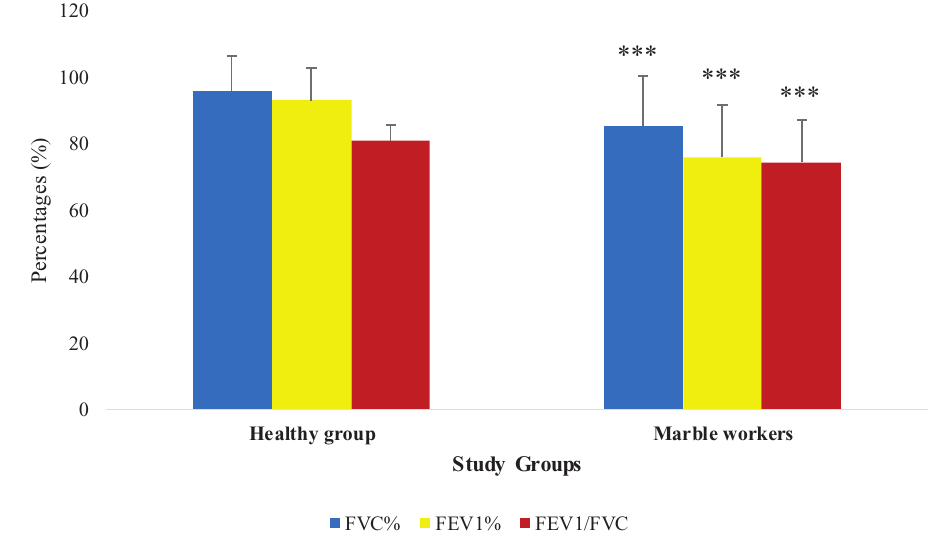
Figure 2. Comparison of pulmonary function parameters (PFTs) by study group (n = 164). Comparison of PFTs (mean (cid:4) SD) in study population. *p-value ≤ 0.05, **p-value ≤ 0.01, ***p-value ≤ 0.001 vs healthy group. Table 3. Distribution of duration of work among marble workshop workers (n = 82).